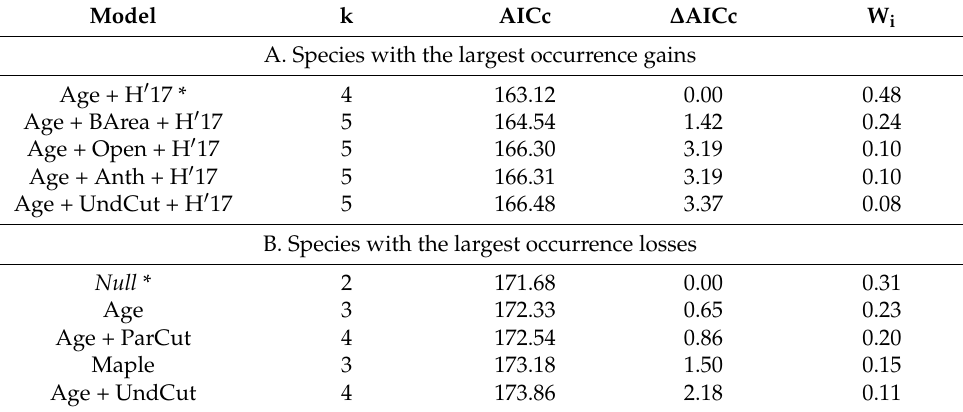
Table 4. Comparison of the five candidate models with the lowest corrected Akaike Information Criteria (AICc), predicting changes in occurrence for (A) the 24 species with the largest gains and (B) the 21 species with the largest losses in the study sites (Q2). The number of parameters (k), the ∆ AICc and the Akaike weight (W i ) of each model are presented. The selected model is denoted by an asterisk ( * ).